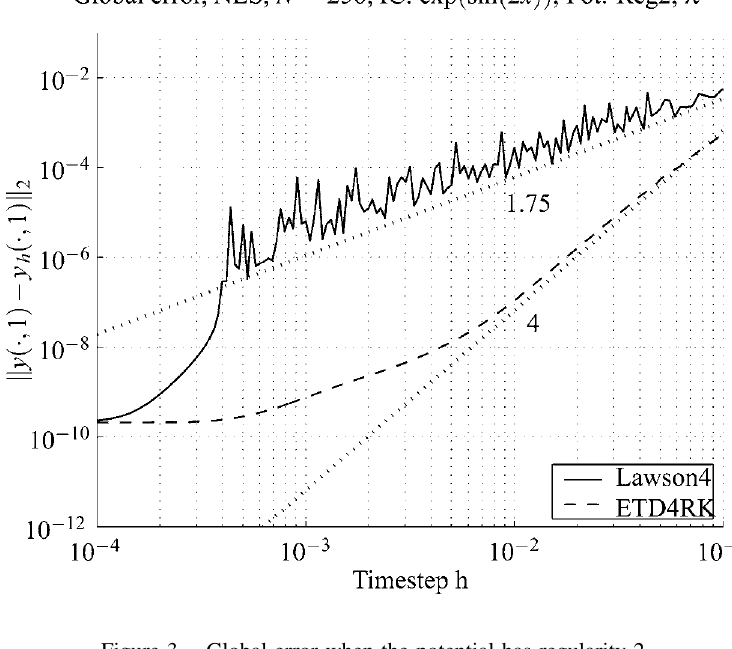
Figure 3. Global error when the potential has regularity 2.